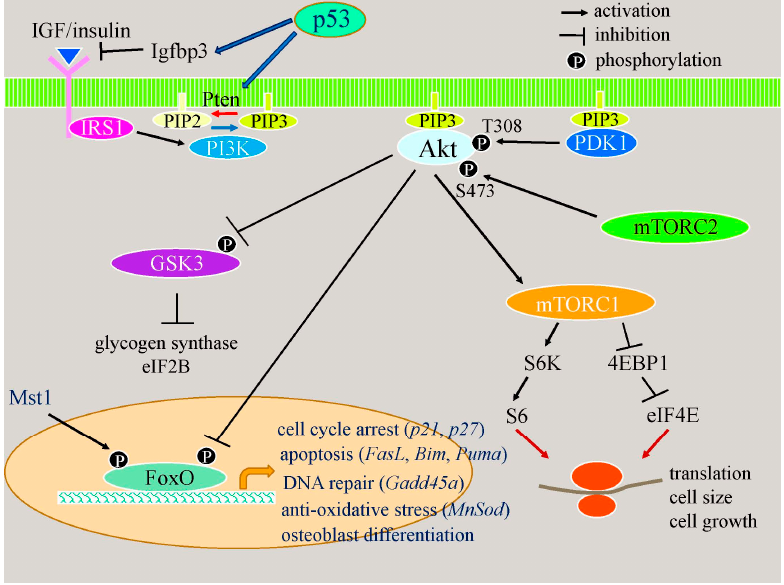
Figure 2. Acceleration of osteoblast differentiation through the p53–Akt–FoxO pathway. p53 induces the expression of Igfbp3 and Pten . Igfbp3 inhibits IGF/insulin binding to the receptor, and Pten dephosphorylates PIP3 to PIP2. PIP3 recruits Akt to the cell membrane and Akt is activated by PDK1 and mTORC2. The decrease in PIP3 inactivates Akt. Akt regulates metabolism, cell growth, cell survival, cell proliferation, and cell differentiation through GSK3, mTORC1, and FoxOs. Akt repair, anti-oxidative stress, and osteoblast